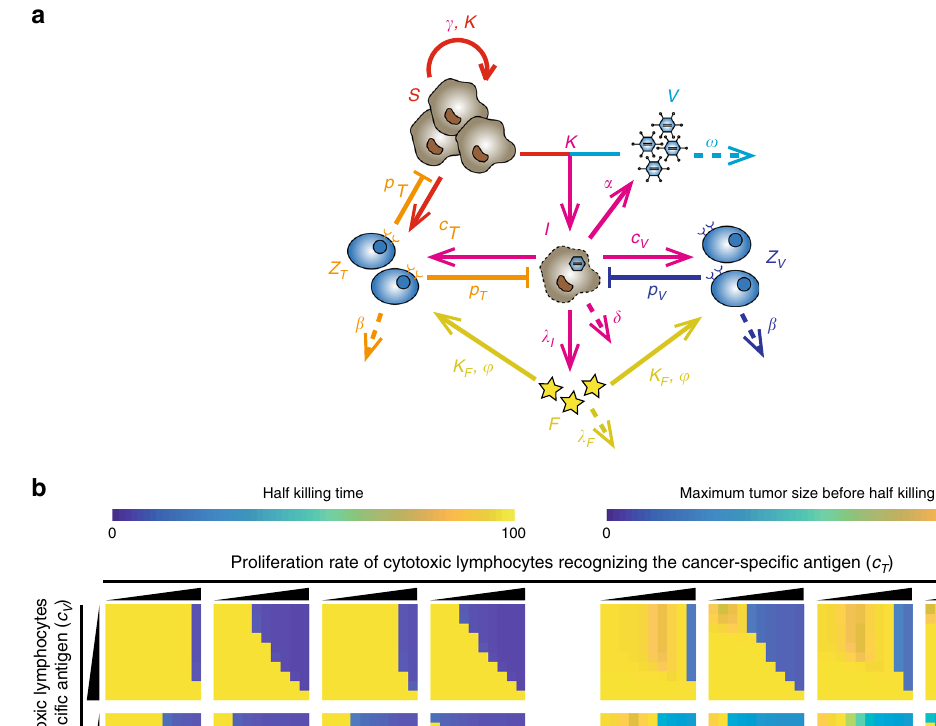
Proliferation rate of cytotoxic lymphocytes recognizing the cancer-specific antigen ( c T )